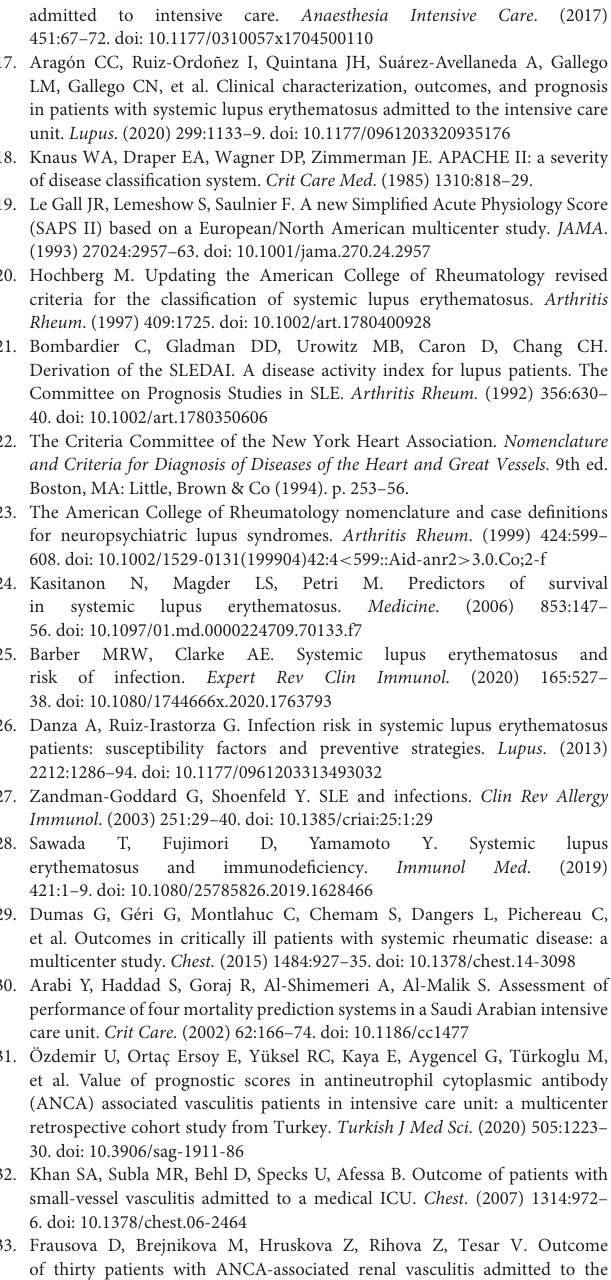
Supplementary Figure 1 | Comparison of the prognostic model with APACHE II. Supplementary Table 1 | Laboratory data on ICU admission of the 391